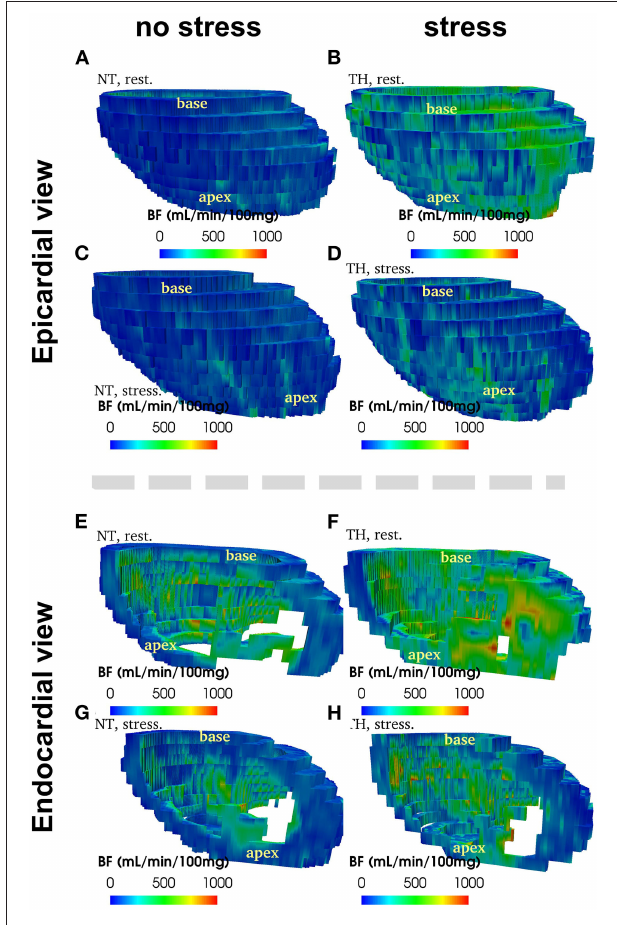
FIGURE 2 | Example of 3D reconstruction of blood flow (in mL/min/100g) segmented from CT images, measured at rest and at stress after adenosine injection, in normothermic (NT) and therapeuric hypothermia (TH) conditions for patient no.